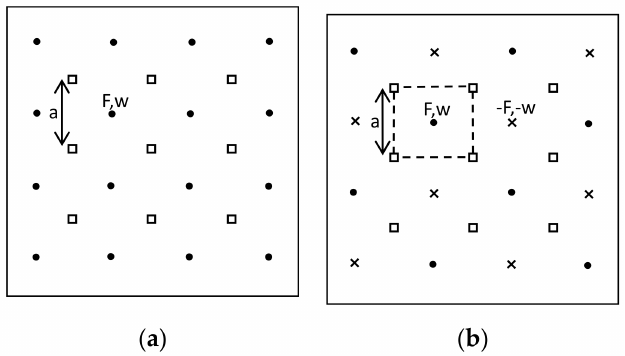
Figure 2. Schematic of a continuous micromirror array with a concentrated load. ( a ) Load in the middle of the plate. ( b ) Load in the middle of the adjacent plate is in the opposite